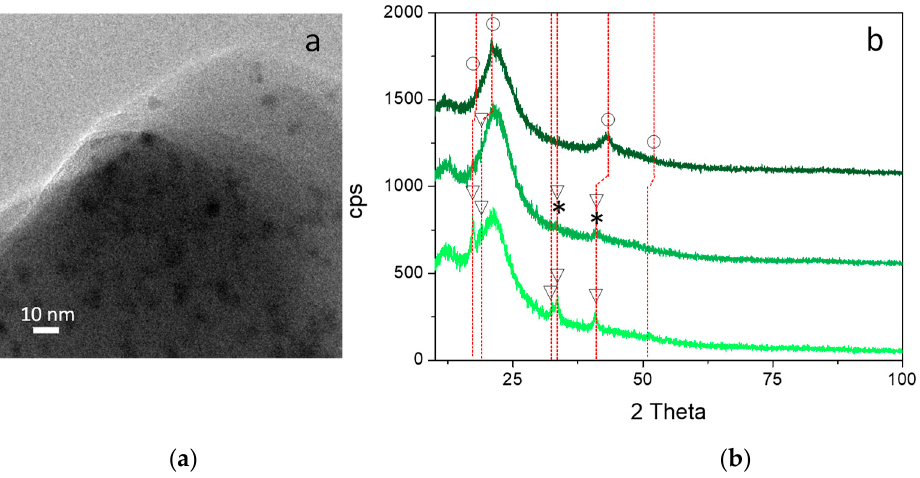
Figure 1. (a ) TEM image of as-prepared Pd/C β CAT. Instrumental magnification 150,000×. ( b ) Powder X-ray diffraction (XRD) patterns of as-prepared Cu/C β CAT (light green line), as prepared PdCu/C β CAT (green line) and of PdCu/C β CAT after reaction (dark green line). The peak positions (green line) and of PdCu / C β CAT after reaction (dark green line). The peak positions are signaled by are signaled by dashed red lines. (Triangles: Copper oxide; asterisks: Metallic palladium; circles: PdCu alloy).